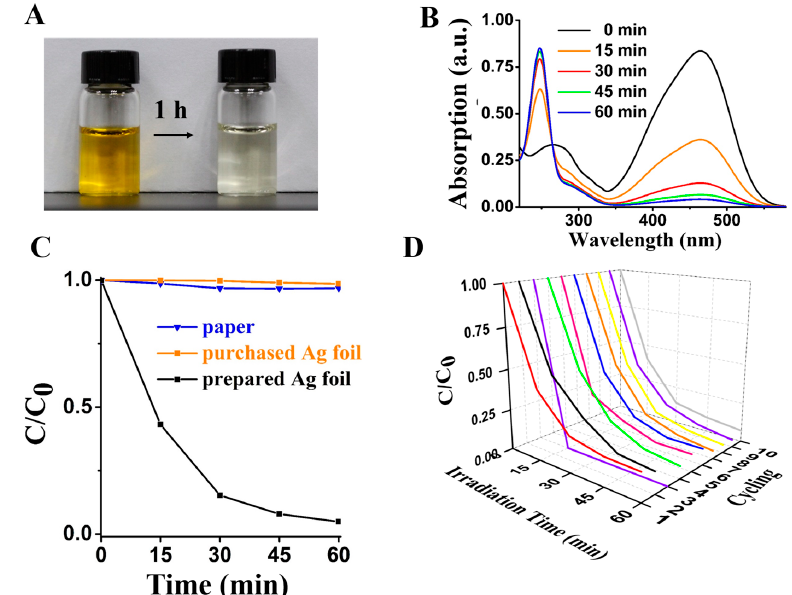
Figure 4. Photocatalytic performance of the paper-templated silver. ( A ) A digital photograph of the MO solution before and after a one-hour irradiation in the presence of the paper-templated silver. ( B ) The absorption-wavelength graph of the MO solutions every 15 min. ( C ) Plot of C/C 0 vs. time in the presence of paper (blue), pure Ag (orange) and the paper-templated silver (dark), where C is the concentration of the MO solution at different times and C 0 is the concentration of the original MO solution. ( D ) Plot of C/C 0 in the presence of the paper-templated silver vs. time for 10 cycles.